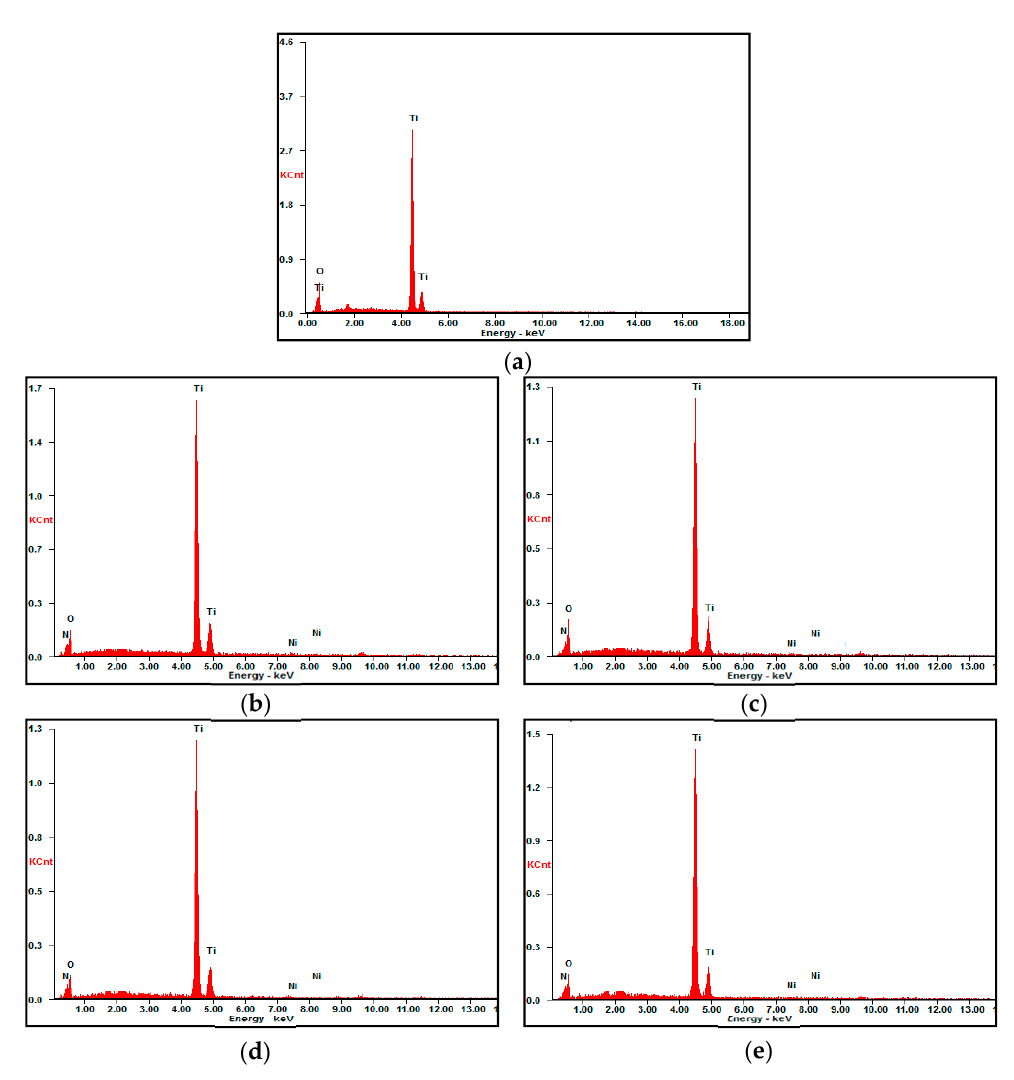
Figure 1. FESEM top image of ( a ) TiNTAs; ( b ) 5 Ni-N-TiNTAs; ( c ) 10%Ni-N-TiNTAs; ( d ) 15%Ni-N- TiNTAs and ( e ) 20%Ni-N-TiNTAs; with a magnification of 100 k.